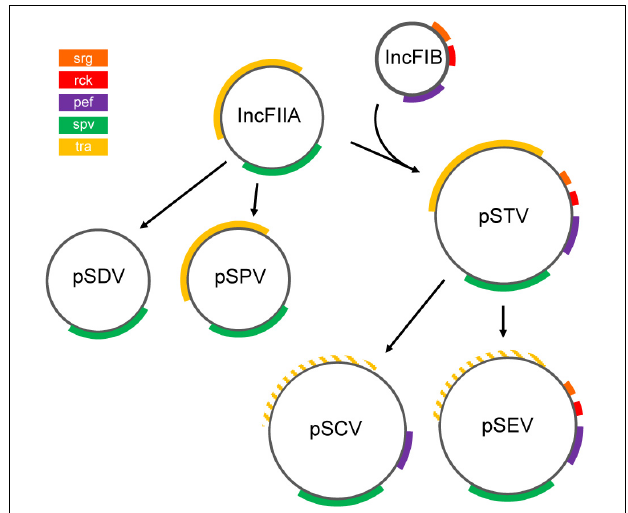
FIGURE 5 | Proposed evolution of NTS virulence plasmids. The ancestral IncFIIA evolved into plasmids pSDV (Dublin) and pSPV (Gallinarum/Pullorum), or fused with replicon IncFIB in the pSTV (Typhimurium) lineage (Rychlik et al., 2006). pSCV (Choleraesuis) and pSEV (Enteritidis) are derived from pSTV (Chu and Chiu, 2006). Colored segments indicate gene clusters. Hatched lines indicate loss of function of the tra locus (Rotger and Casadesús, 1999). Although pSPV encodes tra genes, this plasmid is mobilized via the F-plasmid (Chu and Chiu, 2006). Plasmids and genes are not drawn to scale. This figure is inspired by the theories proposed by Rychlik et al. (2006) and others (Feng et al.,